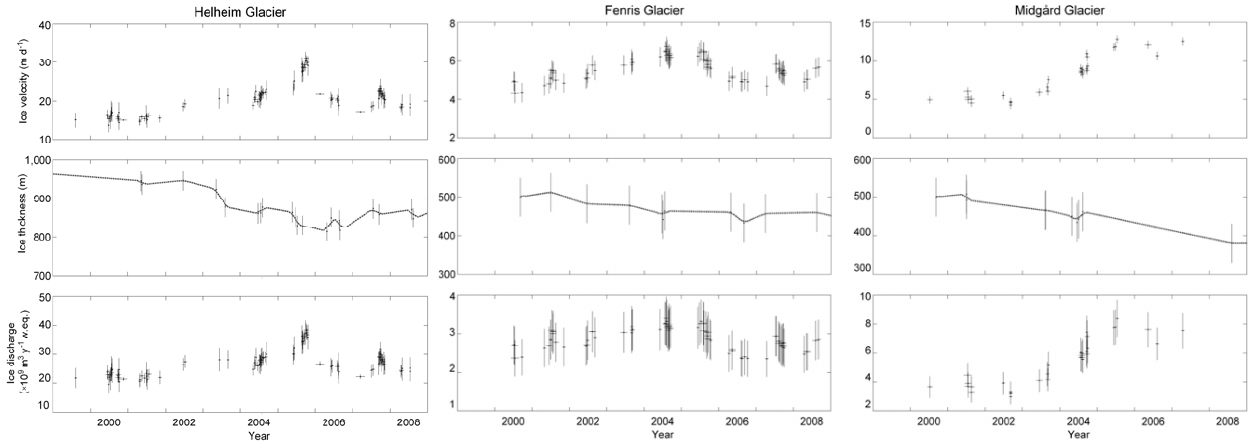
Fig. 6. Satellite-derived time series for the period 1998–2008 of ice velocity, ice thickness, and ice discharge at a stationary flux gate within 3km of the most-retreated front position of the three major outlet glaciers: Helheim Glacier, Fenris Glacier, and Midg˚ard Glacier draining into the Sermilik Fjord. Ice thickness observations (denoted by vertical error bars) were linearly interpolated, denoted by the curve, and multiplied by constant glacier width and observations of ice velocity and the ratio of water and ice densities (0.91) to obtain discharge of water. Ice discharge data for Helheim Glacier reported here are updated from Howat et al. (2005, 2007). Fenris and Midg˚ard Glaciers are located in sub-area 3 and Helheim in sub-area 4.